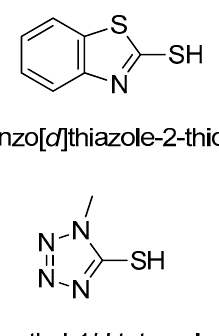
Figure 2. Structures of heterocyclic azoles.